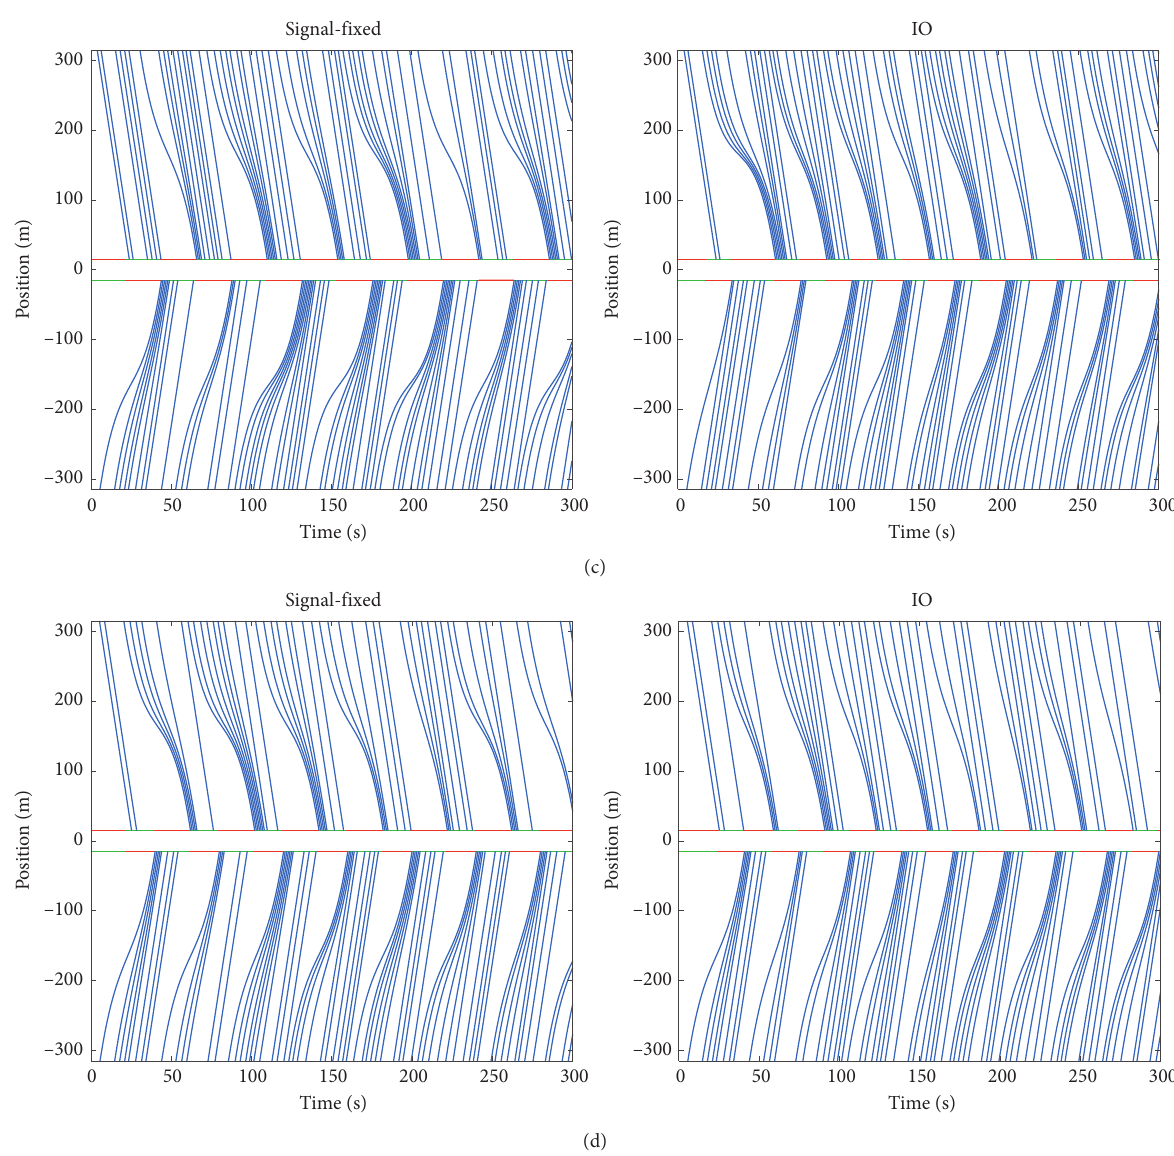
Figure 3: Trajectories of CAVs in arm 1 and 2 as an example. (a) 1200/1200 vph. (b) 1200/800vph. (c) 800/800vph. (d) 800/600